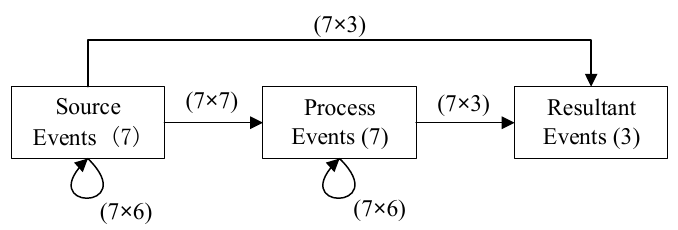
Figure 2. Cross-impact diagram with number of events and number of estimates needed.